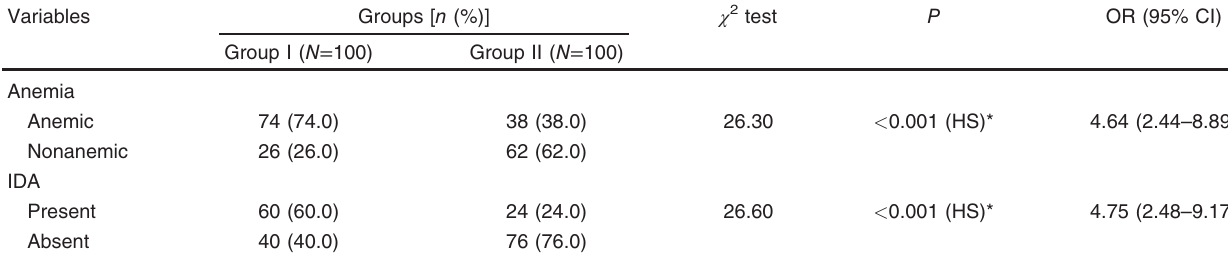
Table 3 Comparison between studied groups regarding presence of anemia and iron-deficiency anemia Variables Groups [ n (%)]